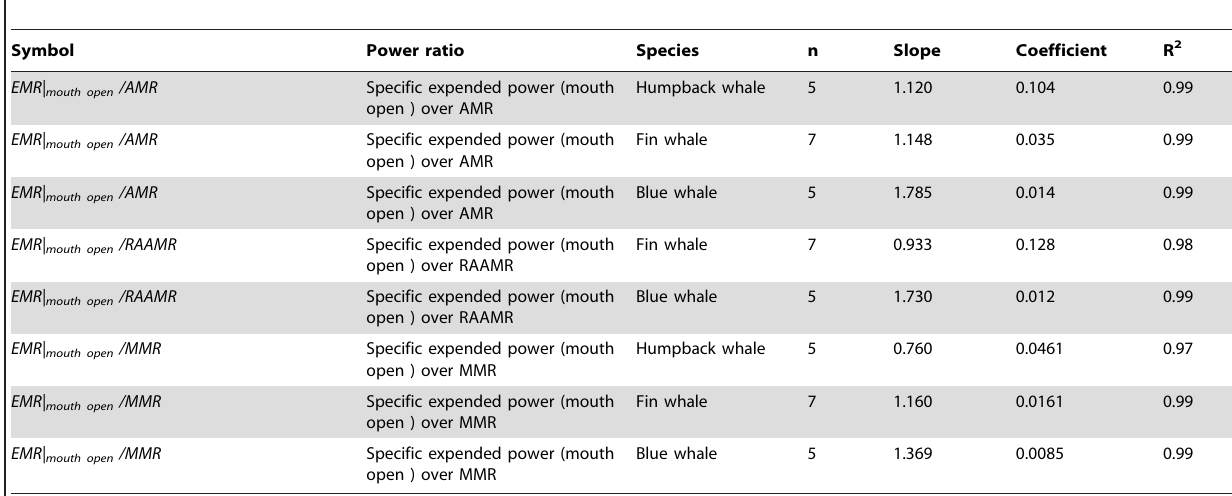
Table 8. Scaling with respect to body length ( L body ) of the expended metabolic power ratios during engulfment (EMR; mouth opening only), as compared with AMR, RAAMR and